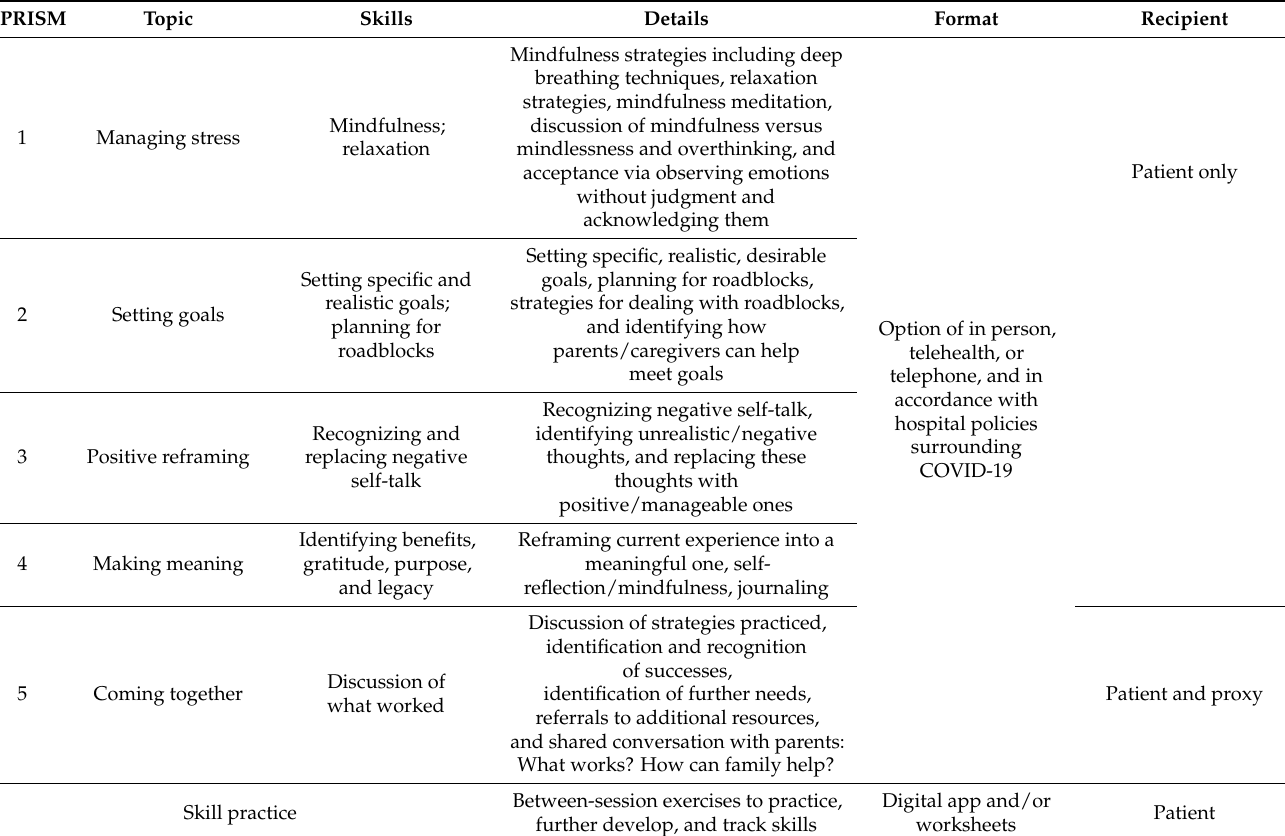
Table 1. PRISM sessions’ content and